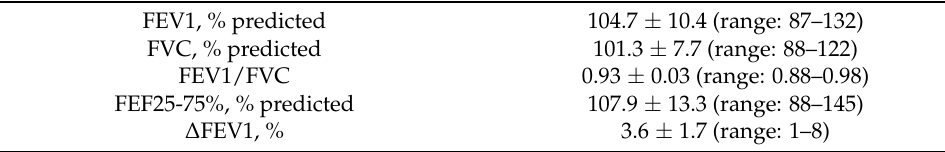
Table 2. Spirometric characteristics (N = 46) *.